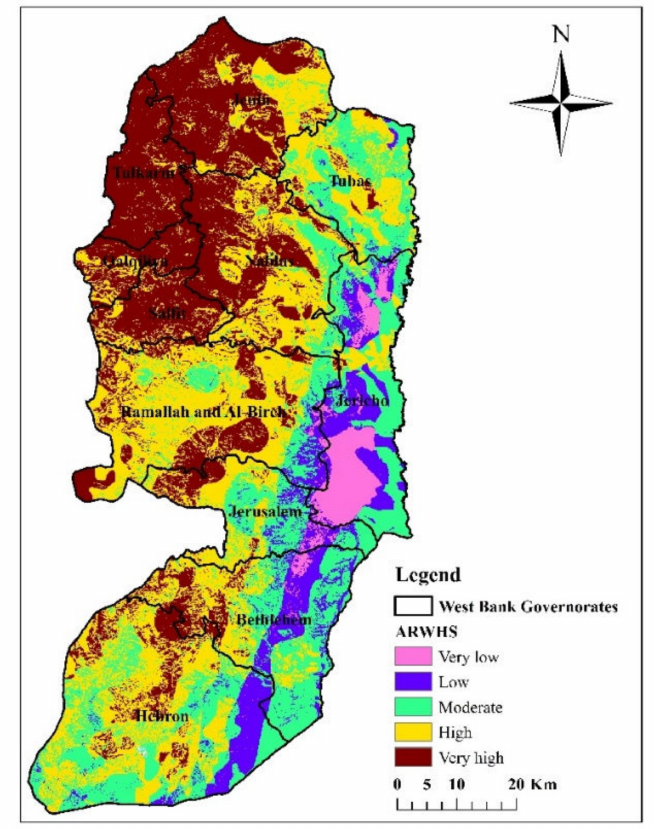
Figure 6. ARWHS map for the West Bank case